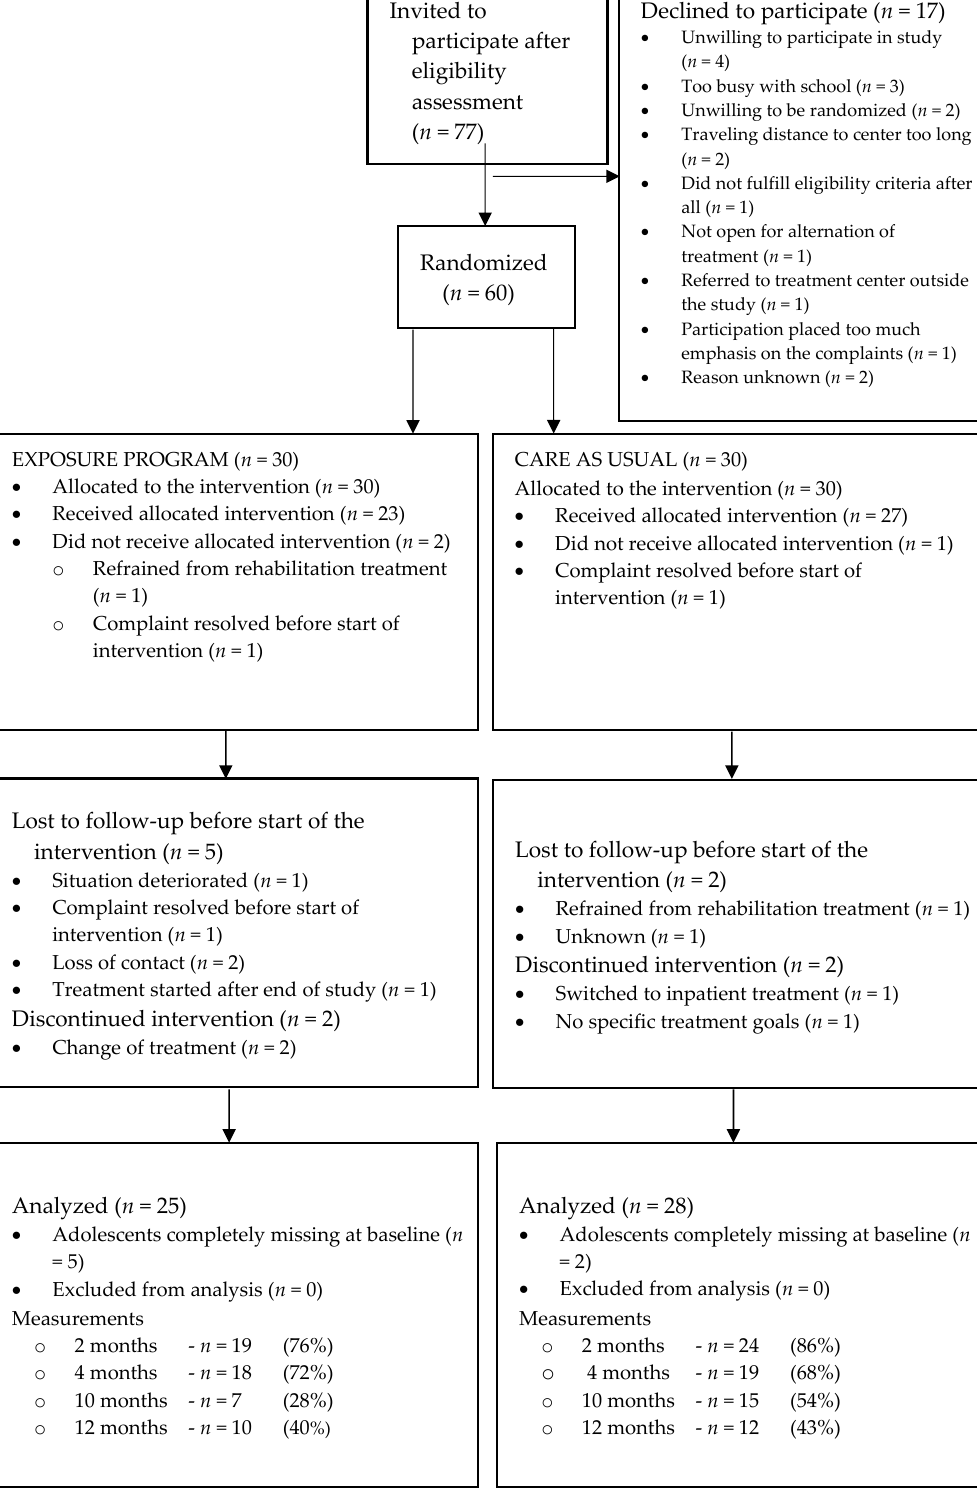
Figure 1. Adolescent flow through the randomized controlled trial (RCT).